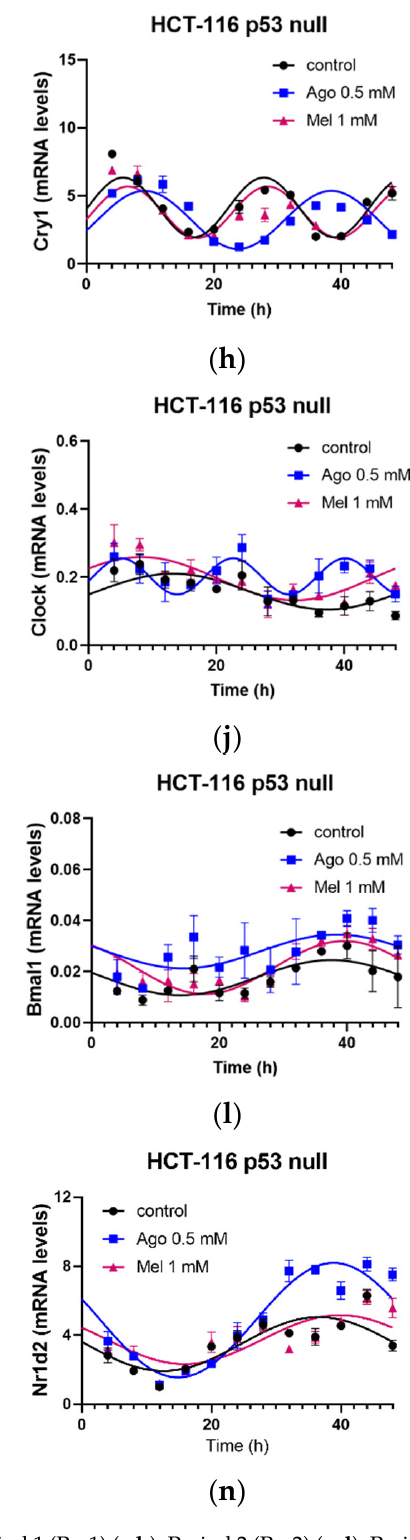
Figure 6. Characteristics of the rhythms obtained for Period 1 (Per1) ( a , b ), Period 2 (Per2) ( c , d ), Period 3 (Per3) ( e , f ), cryptocrome1 (Cry1) ( g , h ), circadian locomotor cycles kaput (Clock) ( i , j ), brain and muscle ARNT-like (Bmal1) ( k , l ) and nuclear receptor subfamily 1 group D member 2 (Nr1d2) ( m , n ) gene after agomelatine (Ago) and melatonin (Mel) treatments in the HCT-116 and HCT-116-p53-null cell lines. Curve fittings under the different conditions were performed using a 48-h test period.